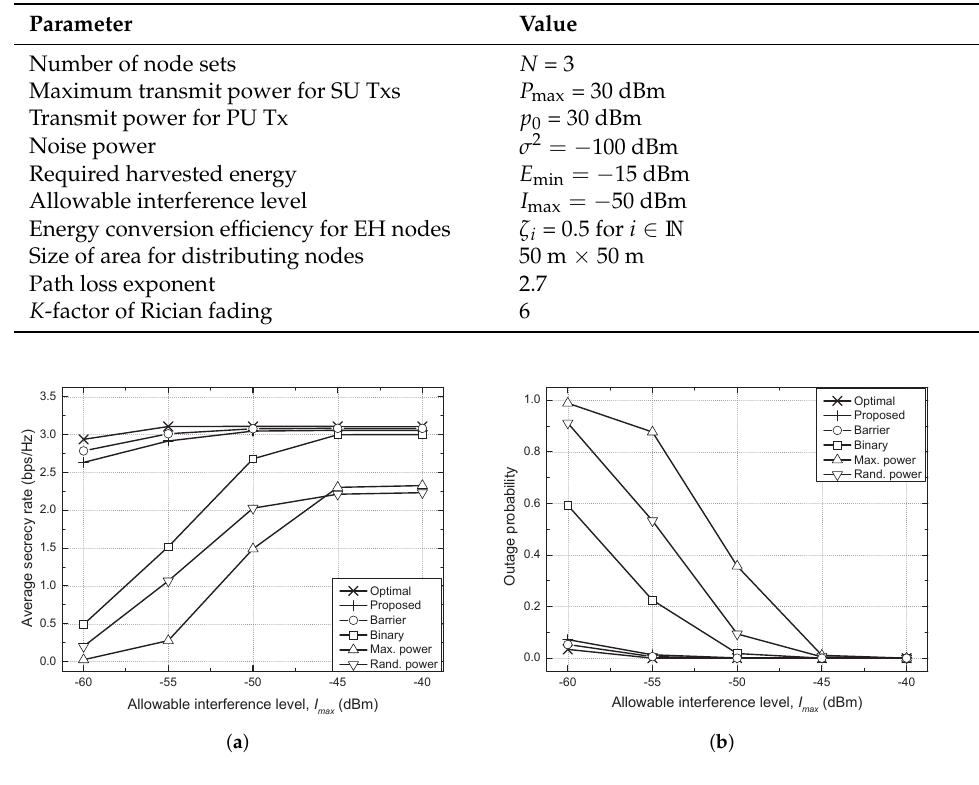
Figure 2. Performance comparison against allowable interference level ( I max ). ( a ) Average secrecy rate vs. I max . ( b ) Outage probability vs. I max